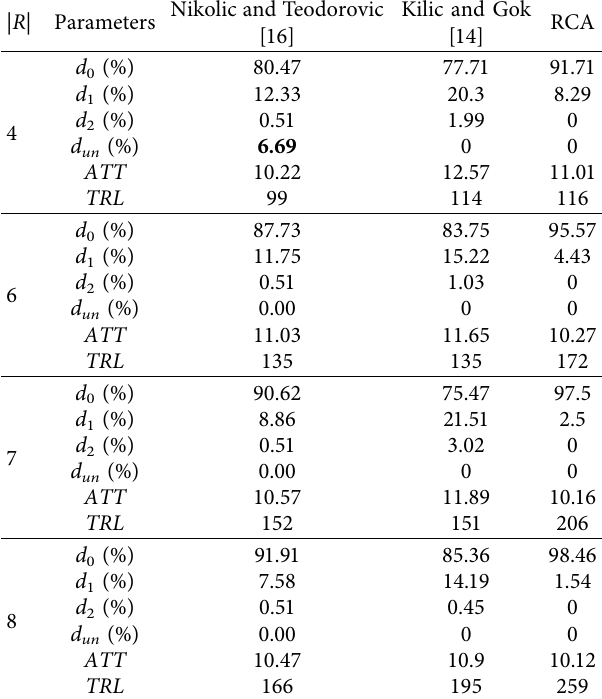
Table 3: Initial solutions for Mandl’s network compared to other